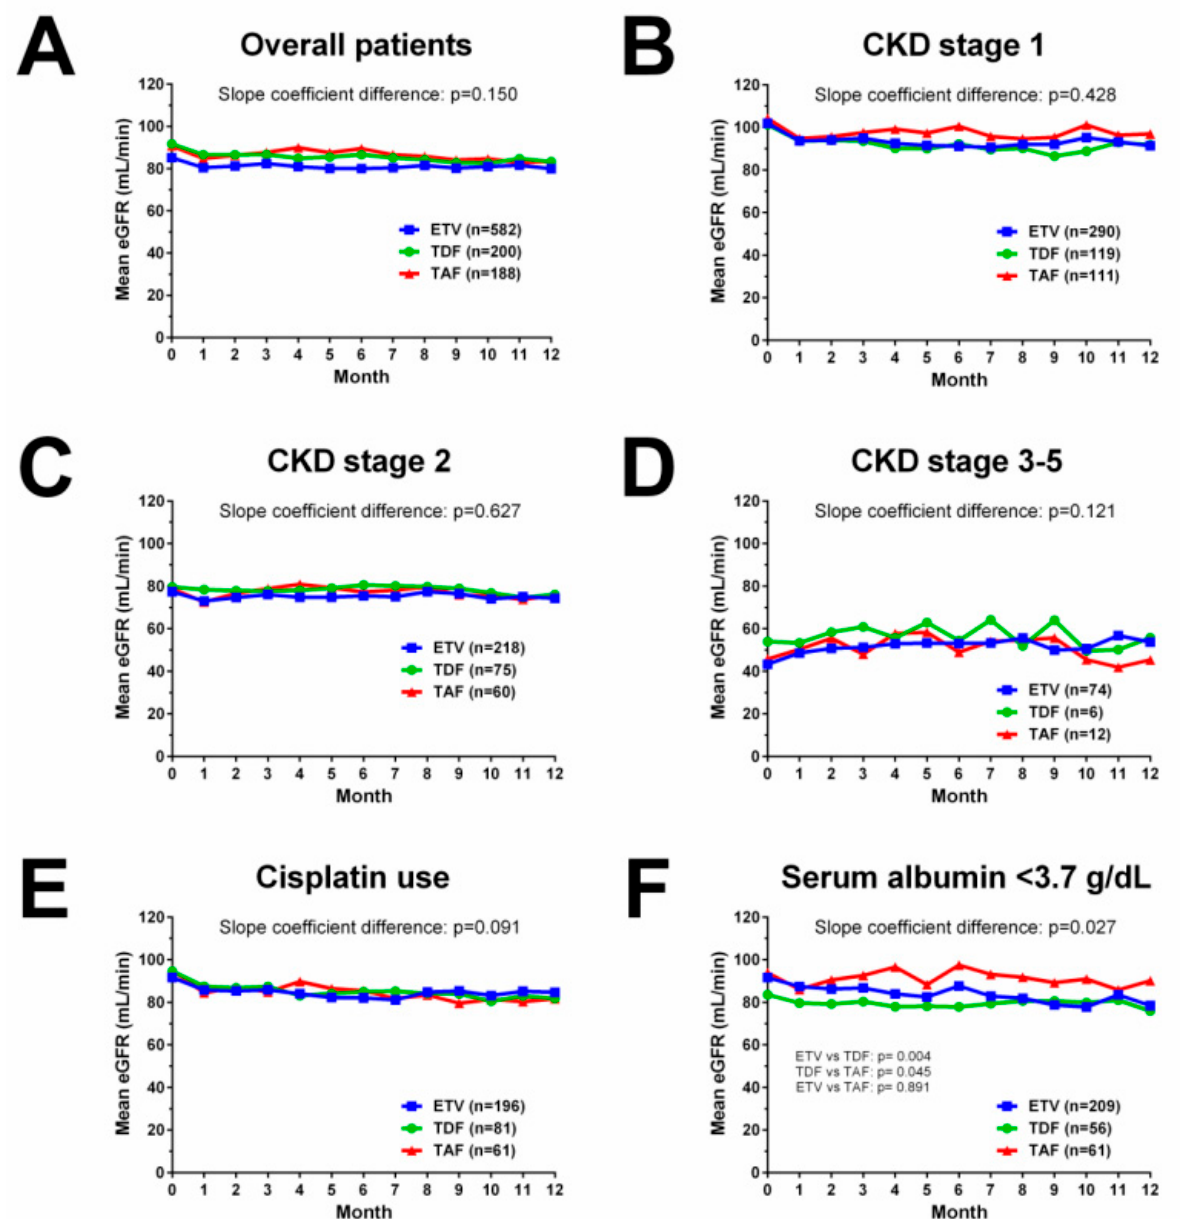
Figure 3. eGFR changes over 1 year during antiviral prophylaxis. ( A ) eGFR changes in overall patients. ( B ) eGFR changes in subgroup patients with CKD stage 1. ( C ) eGFR changes in subgroup patients with CKD stage 2. ( D ) eGFR changes in subgroup patients with CKD stage 3–5. ( E ) eGFR changes in subgroup patients with cisplatin use. ( F ) eGFR changes in subgroup patients with serum albumin <3.7